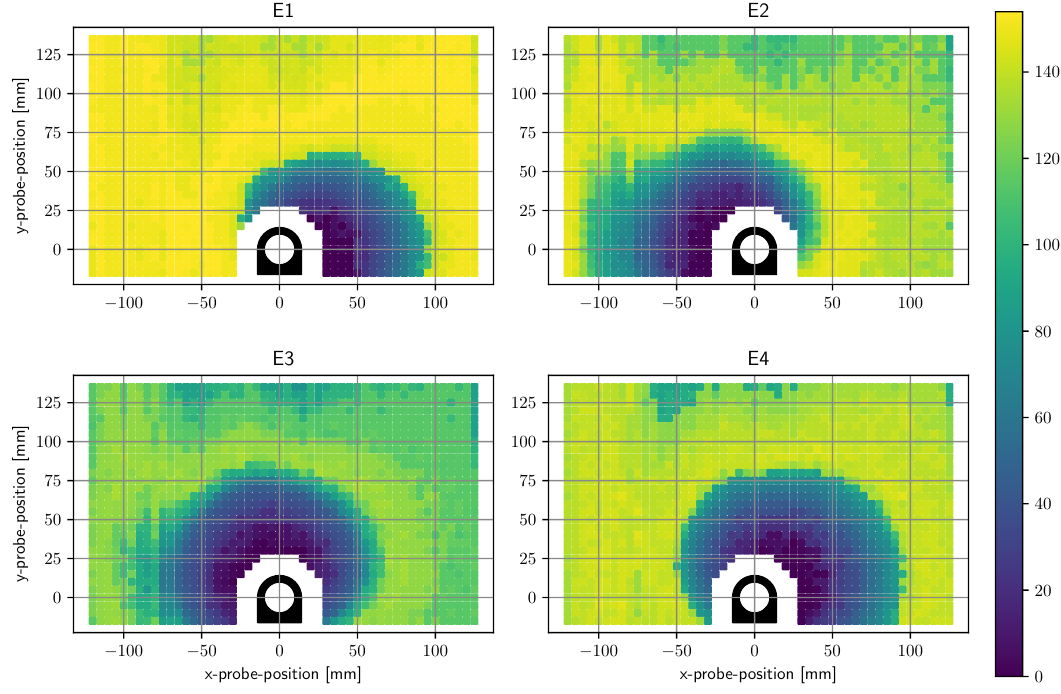
Figure 7. Spatial resolution for each electrode. The color represents the particular resolution in millimeters.